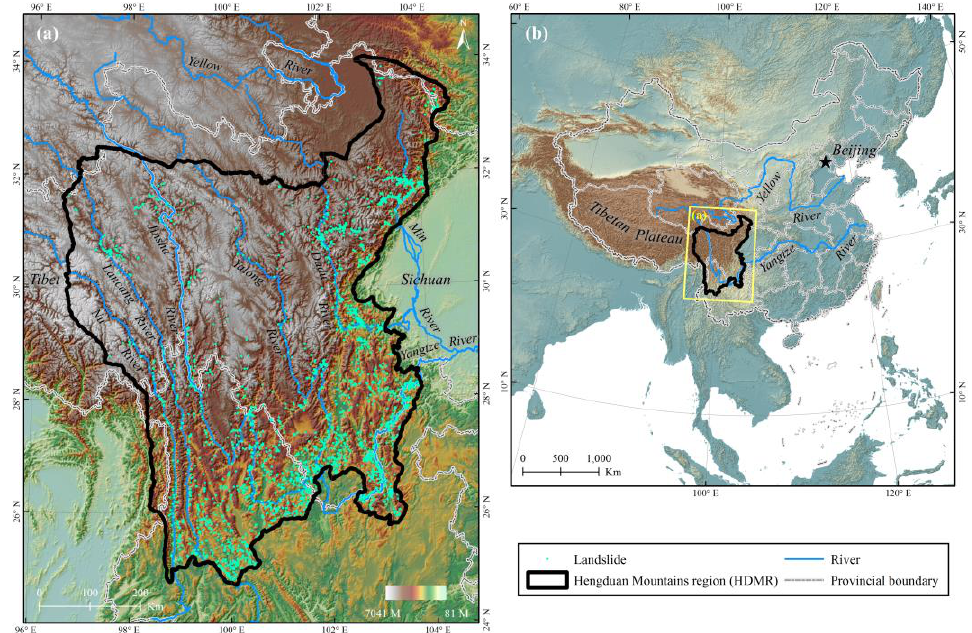
Figure 5. Hengduan Mountain region (HDMR). Landslides used in susceptibility analysis are shown in ( a ). Location of the HDMR relative to the Tibetan Plateau is shown in ( b ).